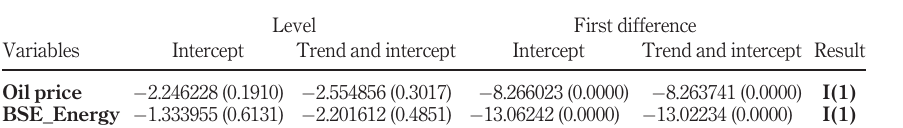
Table 3. Results of PP unit